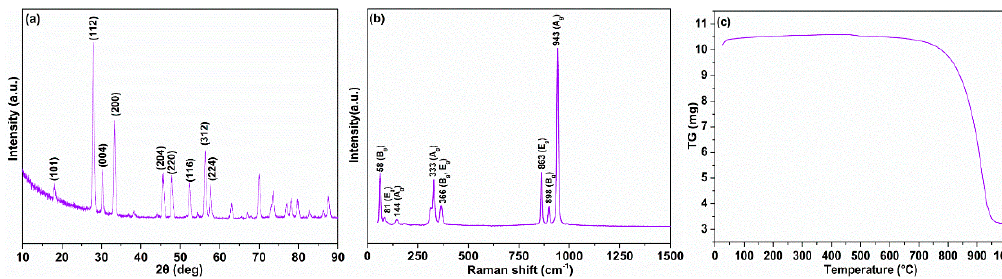
Figure 2. The XRD pattern, Raman spectra, and Thermogravimetric (TG) curve of as-synthesized product. ( a ) XRD pattern; ( b ) Raman spectra; ( c ) TG curve.